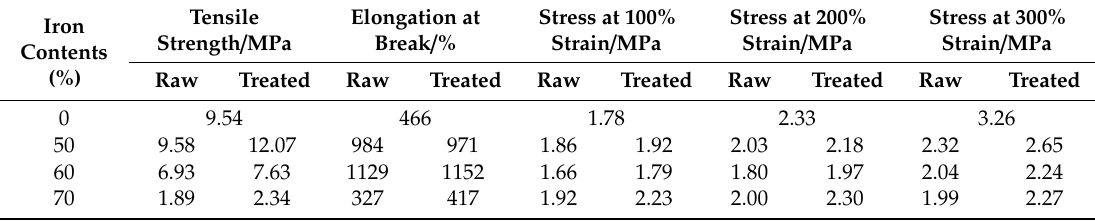
Table 1. Mechanical characteristics of anisotropic polyurethane (PU) MREs with di ff erent CI concentrations [79].